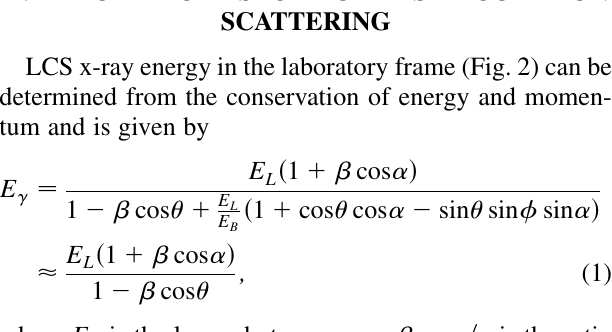
and u are the x-ray and detector direc- (cid:1) d ; (cid:5) ) are the x-ray and detector d d (cid:5) are the x-ray and detec- ; (cid:5) d d is the laser polarization direc- L